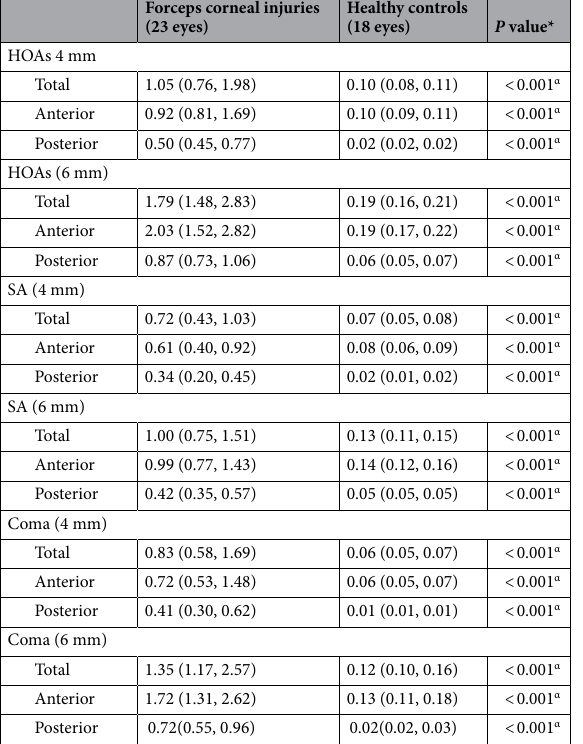
Table 2. Corneal higher-order aberrations in bullous keratopathy due to forceps corneal injuries. Data is shown by median (IQR) μm. HOAs, higher-order aberrations; IQR, interquartile range; SA, spherical aberration. α P values: Mann–Whitney test.